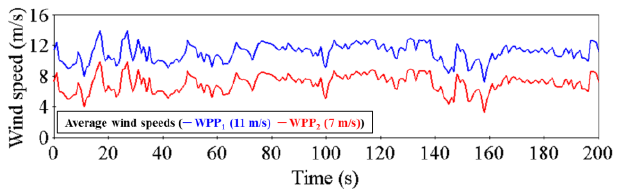
Figure 6. Input wind speeds for WPPs.